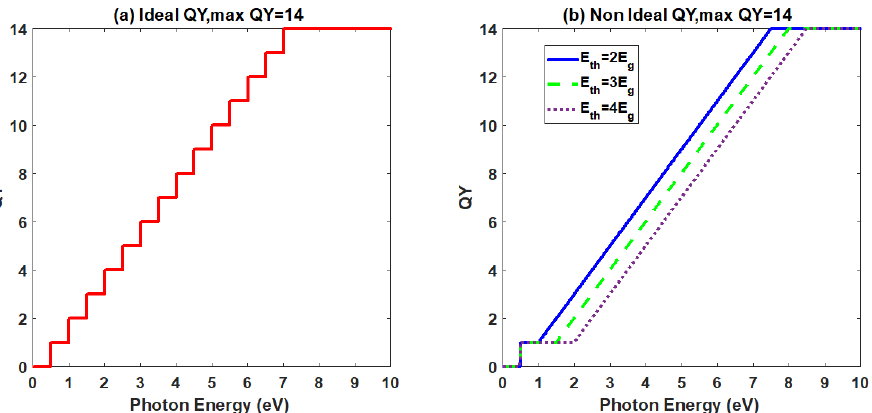
Figure 2. Ideal quantum yield (IQY) (maximum QY = 14) and nonideal quantum yields (NQYs) with three different threshold energies (2Eg, 3Eg, and 4Eg), where Eg = 0.5 eV.